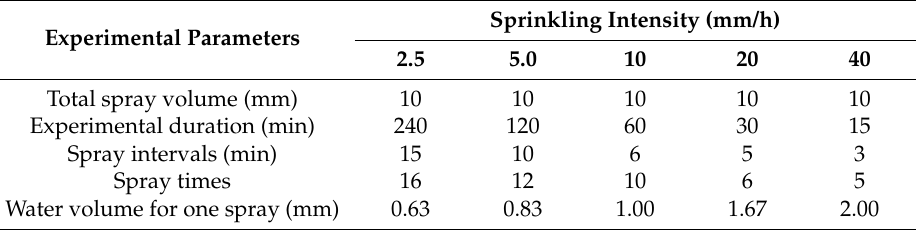
Table 1. Detailed designs of sprinkling interception